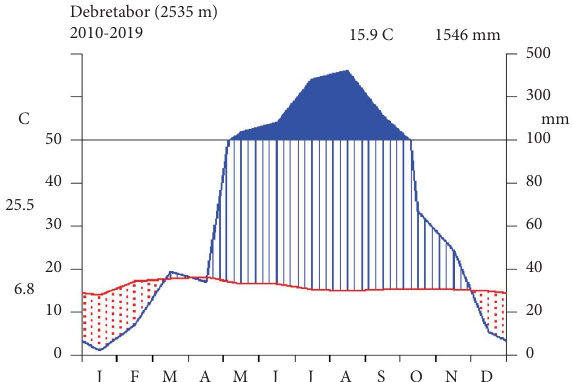
Figure 2: Climate diagram of the study area from 2010–2019 at Debre Tabor station source: National Meteorological